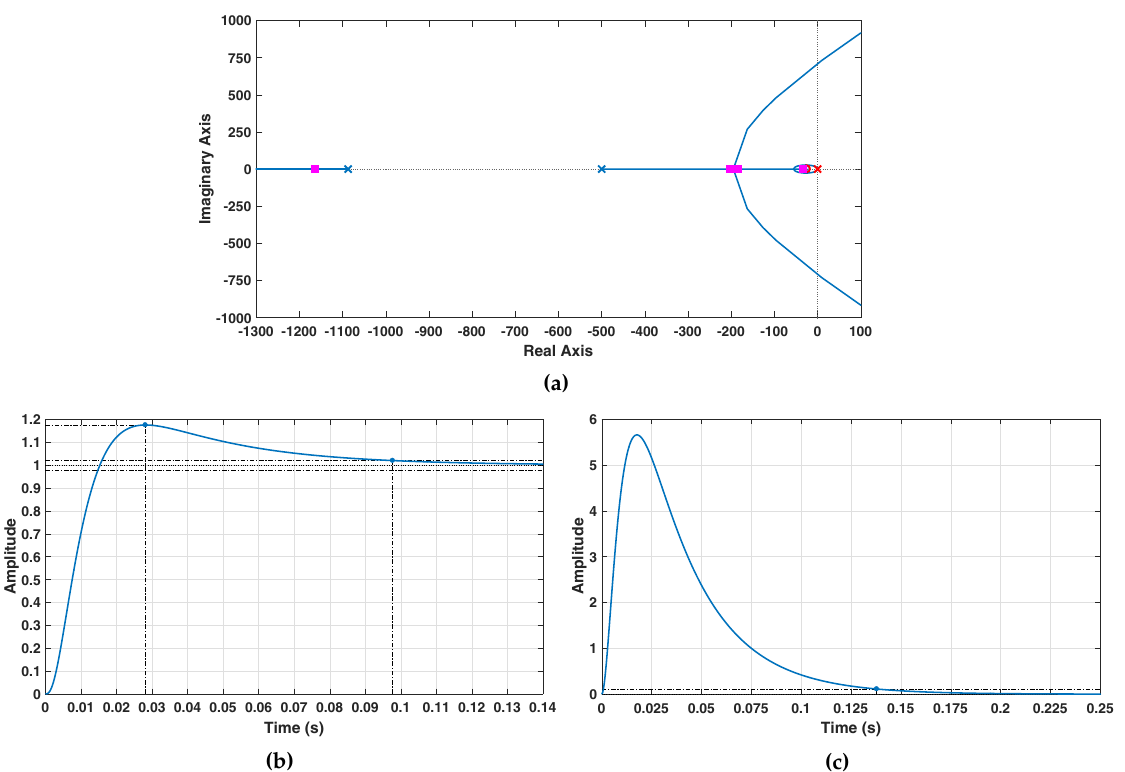
Figure 10. ( a ) locations of the closed-loop poles for the control subsystem of the voltage v DC 2 ; ( b ) time responses of the voltage v DC 2 for a unit step in the reference v ∗ DC 2 ; ( c ) time responses of the voltage v DC 2 for a unit step in the disturbance i DC − DC